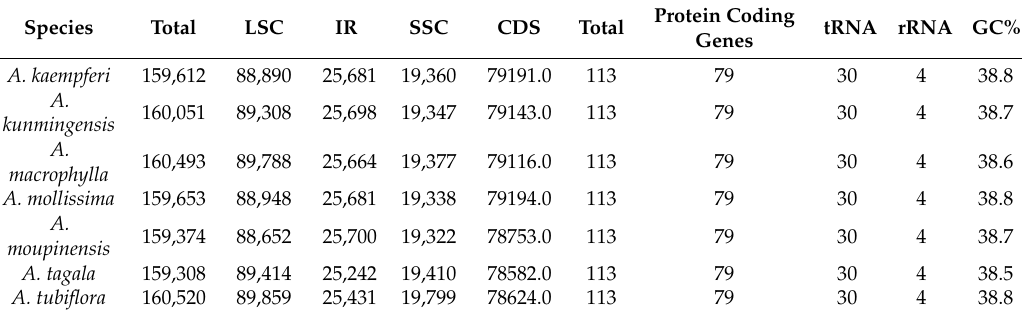
Figure 1. Gene maps of the complete cp genome of seven species of Aristolochia . Gene map of cp genome of ( A ) Aristolochia manshuriensis ; ( B ) Aristolochia kaempferi , Aristolochia macrophylla , Aristolochia mollissima and Aristolochia kunmingensis ; ( C ) Aristolochia tagala and Aristolochia tubiflora . Genes on the inside of the circle are transcribed clockwise, while those outside are transcribed counter clockwise. The darker gray in the inner circle corresponds to GC content, whereas the lighter gray corresponds to AT content. Table 1. Summary of complete chloroplast (cp) genomes of Aristolochia